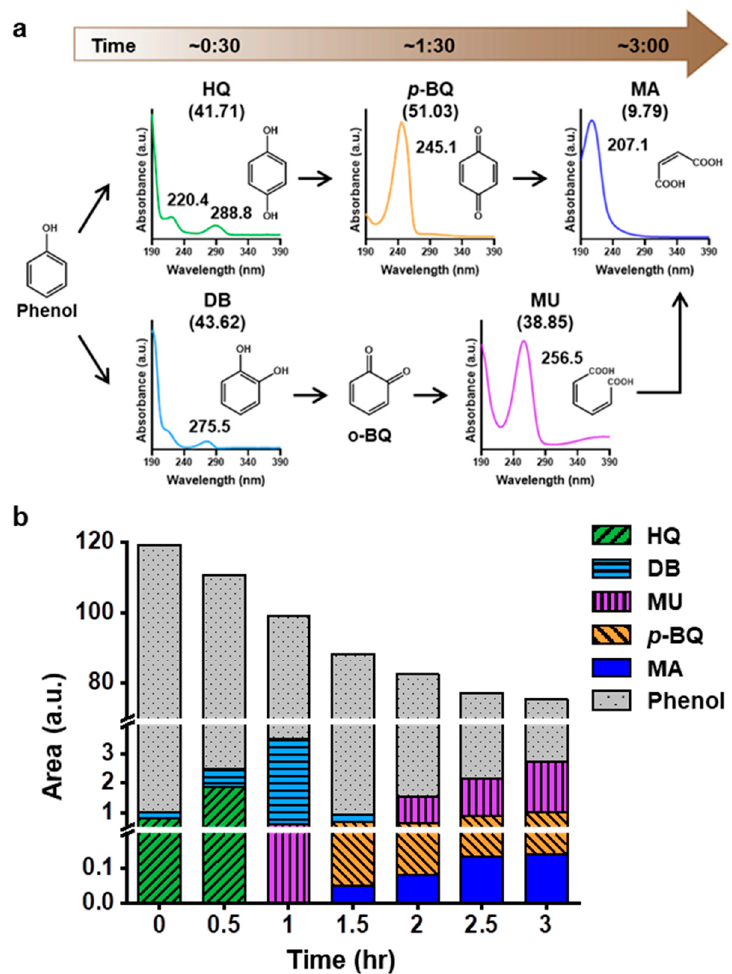
Figure 4. Analysis of oxidized derivatives from phenol. ( a ) Summarized diagram of the phenol degradation process with the UV spectra of intermediates detected at each retention time and experimental time point. ( b ) The change in the area under the HPLC curve of phenol and each intermediate.